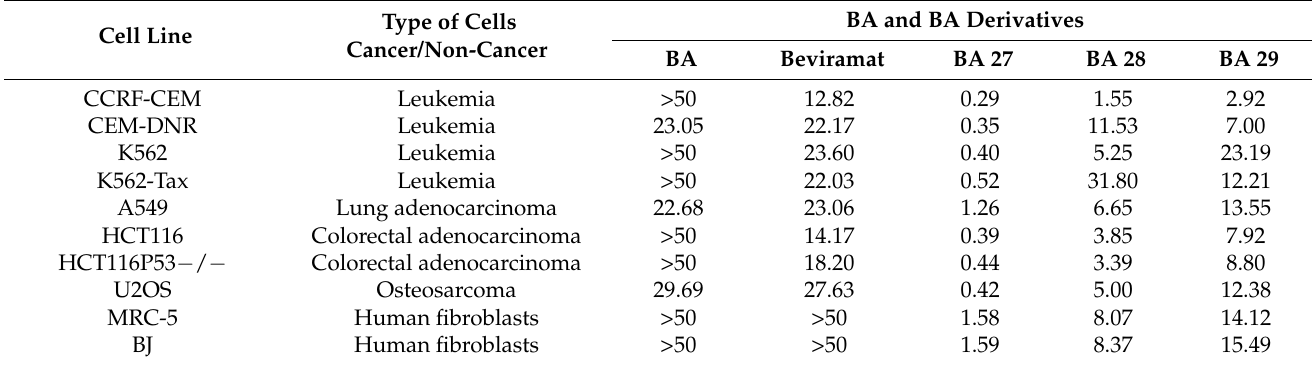
Table 3. In vitro cytotoxicity of BA-aminopropyl and BA-piperazinyl derivatives (IC 50 ; µ